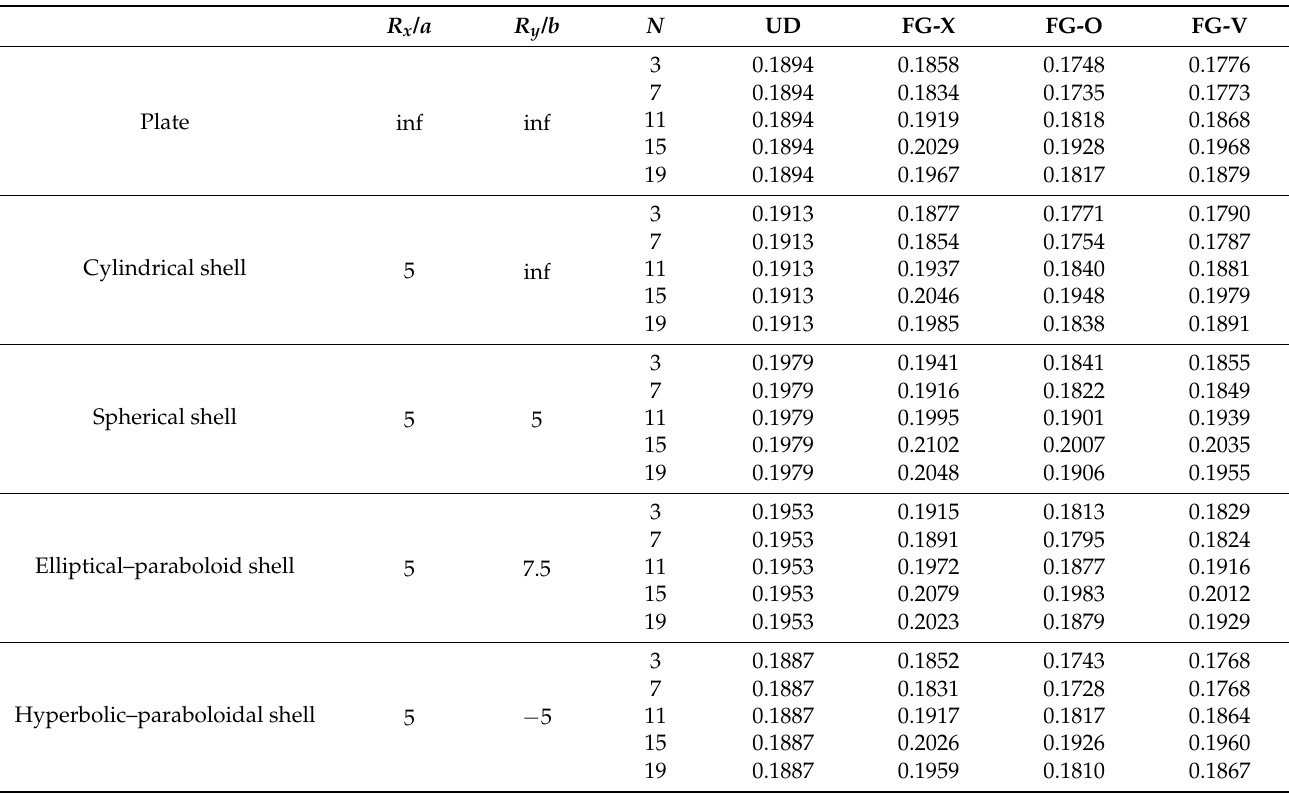
Table 6. The effect of the number of layers and fiber distribution patterns on the dimensionless frequency of unidirectional F/CNT-RC shells for various curvature radii (SSSS, b / a = 1, a / h = 10,